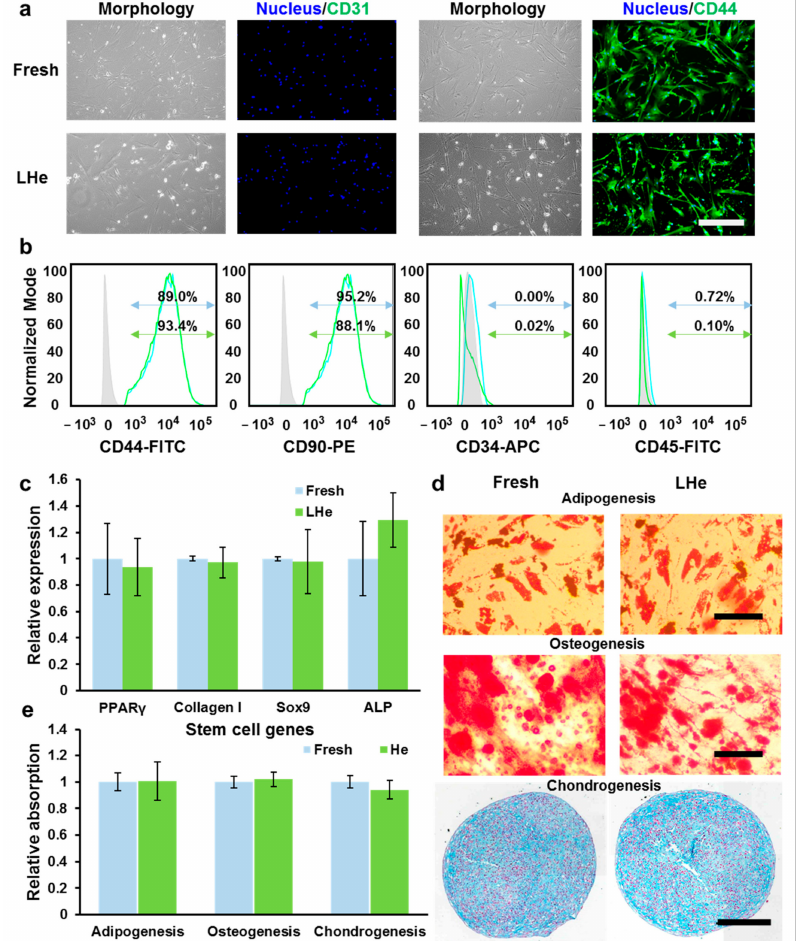
Figure 6. The hBMSCs retained stemness and differentiation ability after vitrification in LHe. ( a ) Im- munofluorescence staining of vitrified hBMSCs showed the high expression of stem cell markers CD44 and the low expression of CD31. ( b ) Flow cytometry quantificationally evaluated the expression of CD44 high , CD90 high , CD34 low , and CD45 low . Blue: fresh group; Green: LHe group. ( c ) RT-qPCR analysis evaluated the relative expression of four hBMSCs genes (PPARy, Collagen I, Sox9, and ALP) after vitrification in LHe. There was no significant difference between group Fresh and